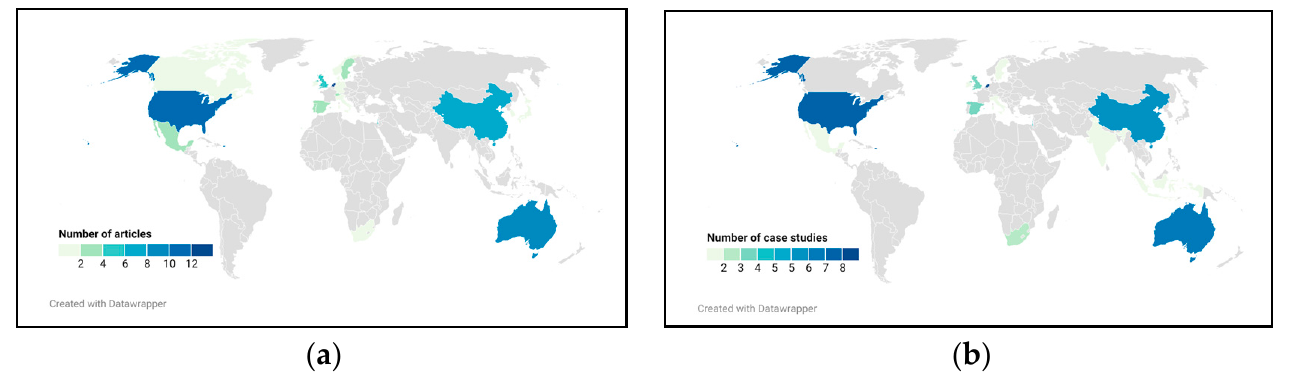
Figure 3. ( a ) Geographical distribution of the articles considered in this article (1st author). Figure source: Datawrapper; ( b ) Geographical distribution of the case studies considered in the article. Figure source: Datawrapper.